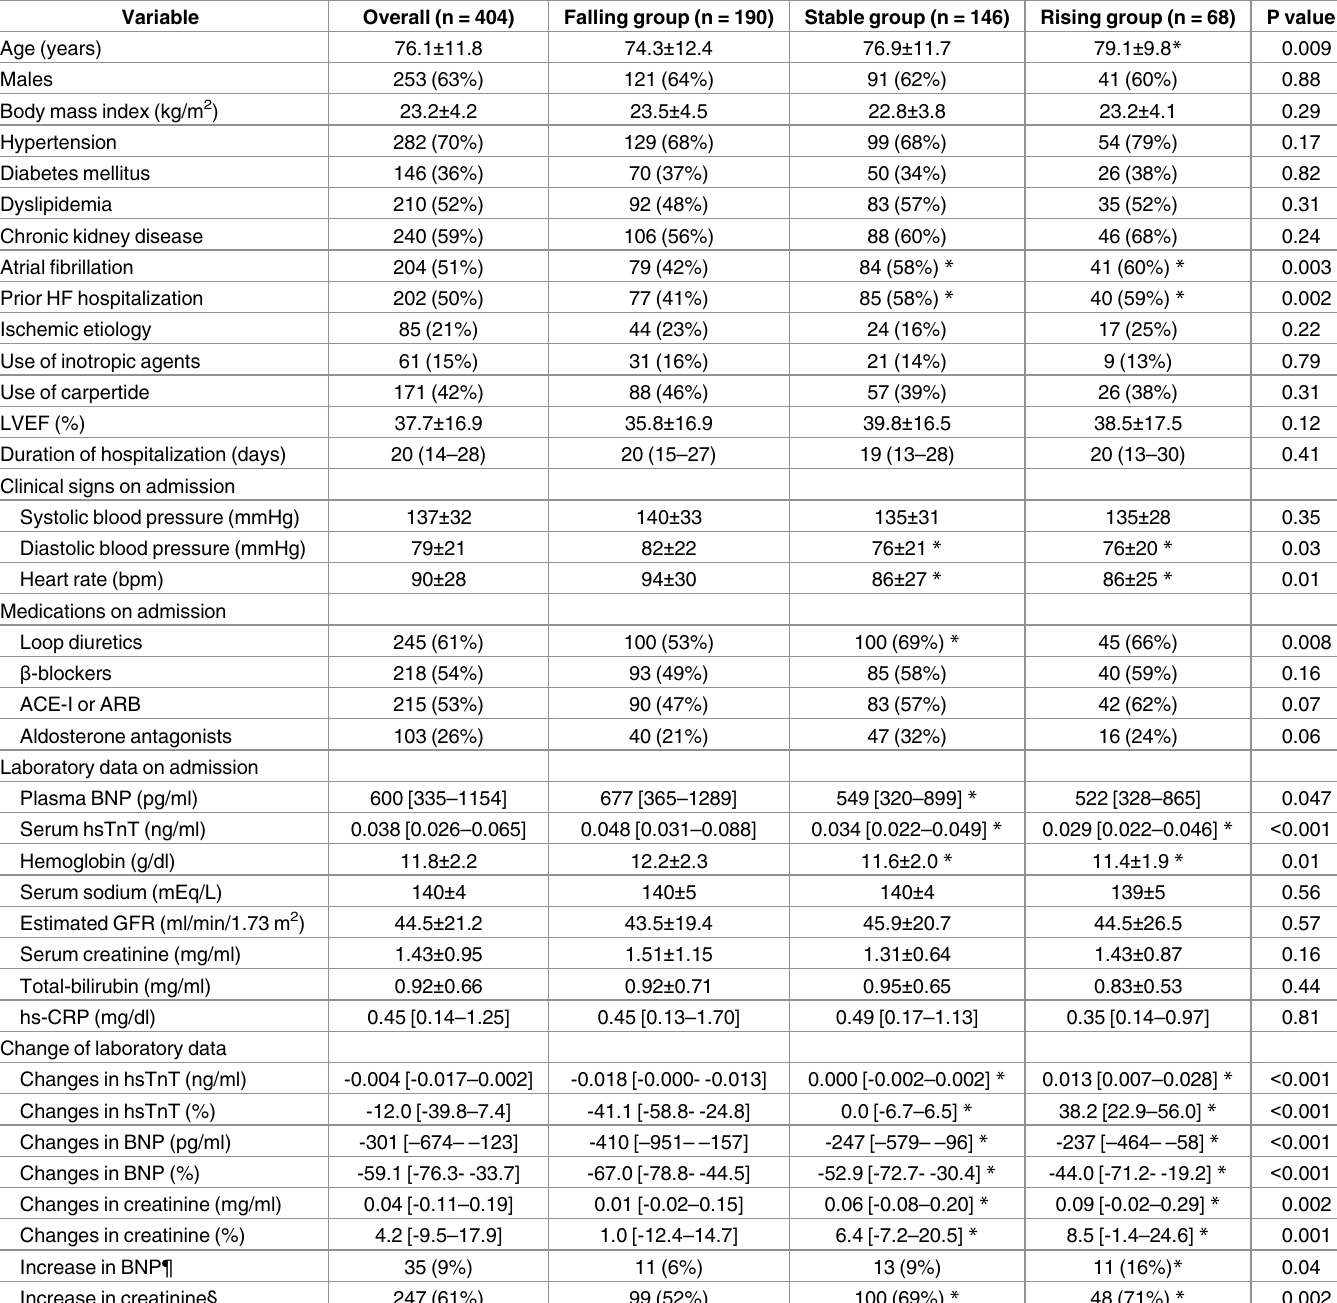
Table 1. Clinical characteristics of patients of the hsTnT falling, stable or rising